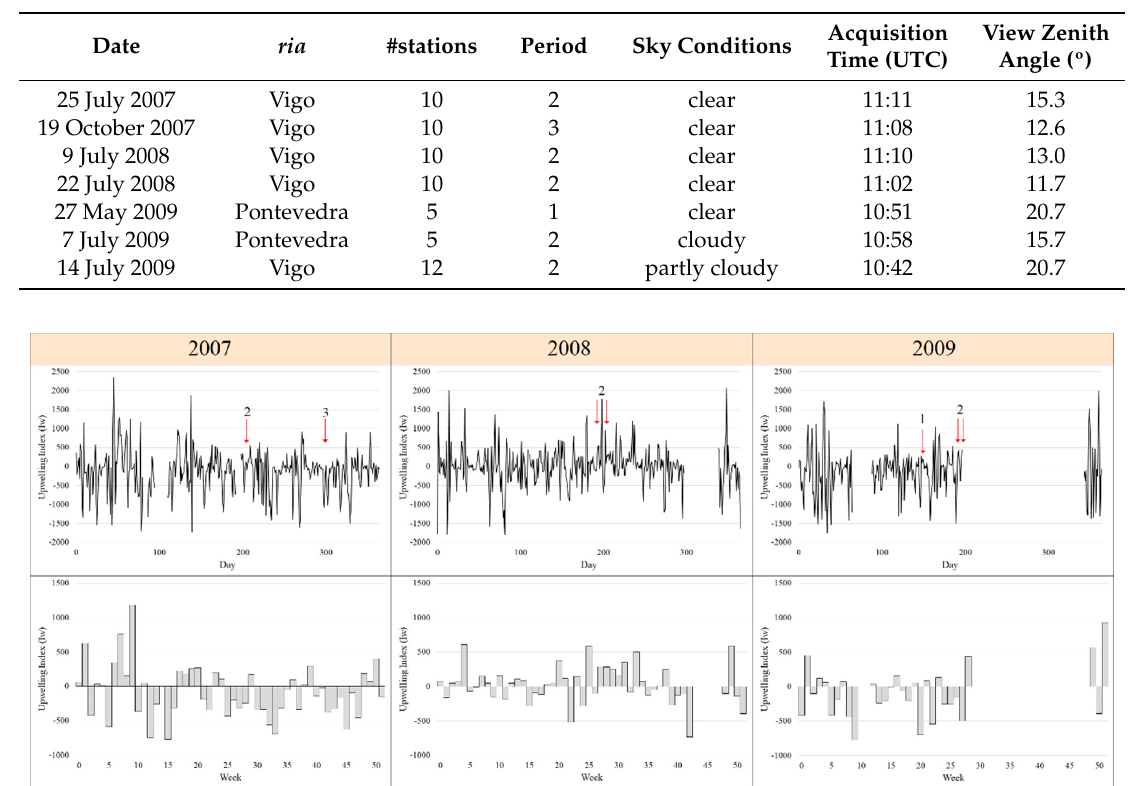
Table 1. Summary of the field campaign, showing date, ria , number of sampling stations (#stations), period (between 1 and 3), sky conditions and the acquisition time and mean view zenith angle from west for the MERIS FR images used in this study. The three periods were: 1: Spring downwelling favourable winds; 2: summer upwelling-downwelling cycle and 3: autumn strong downwelling favourable winds.